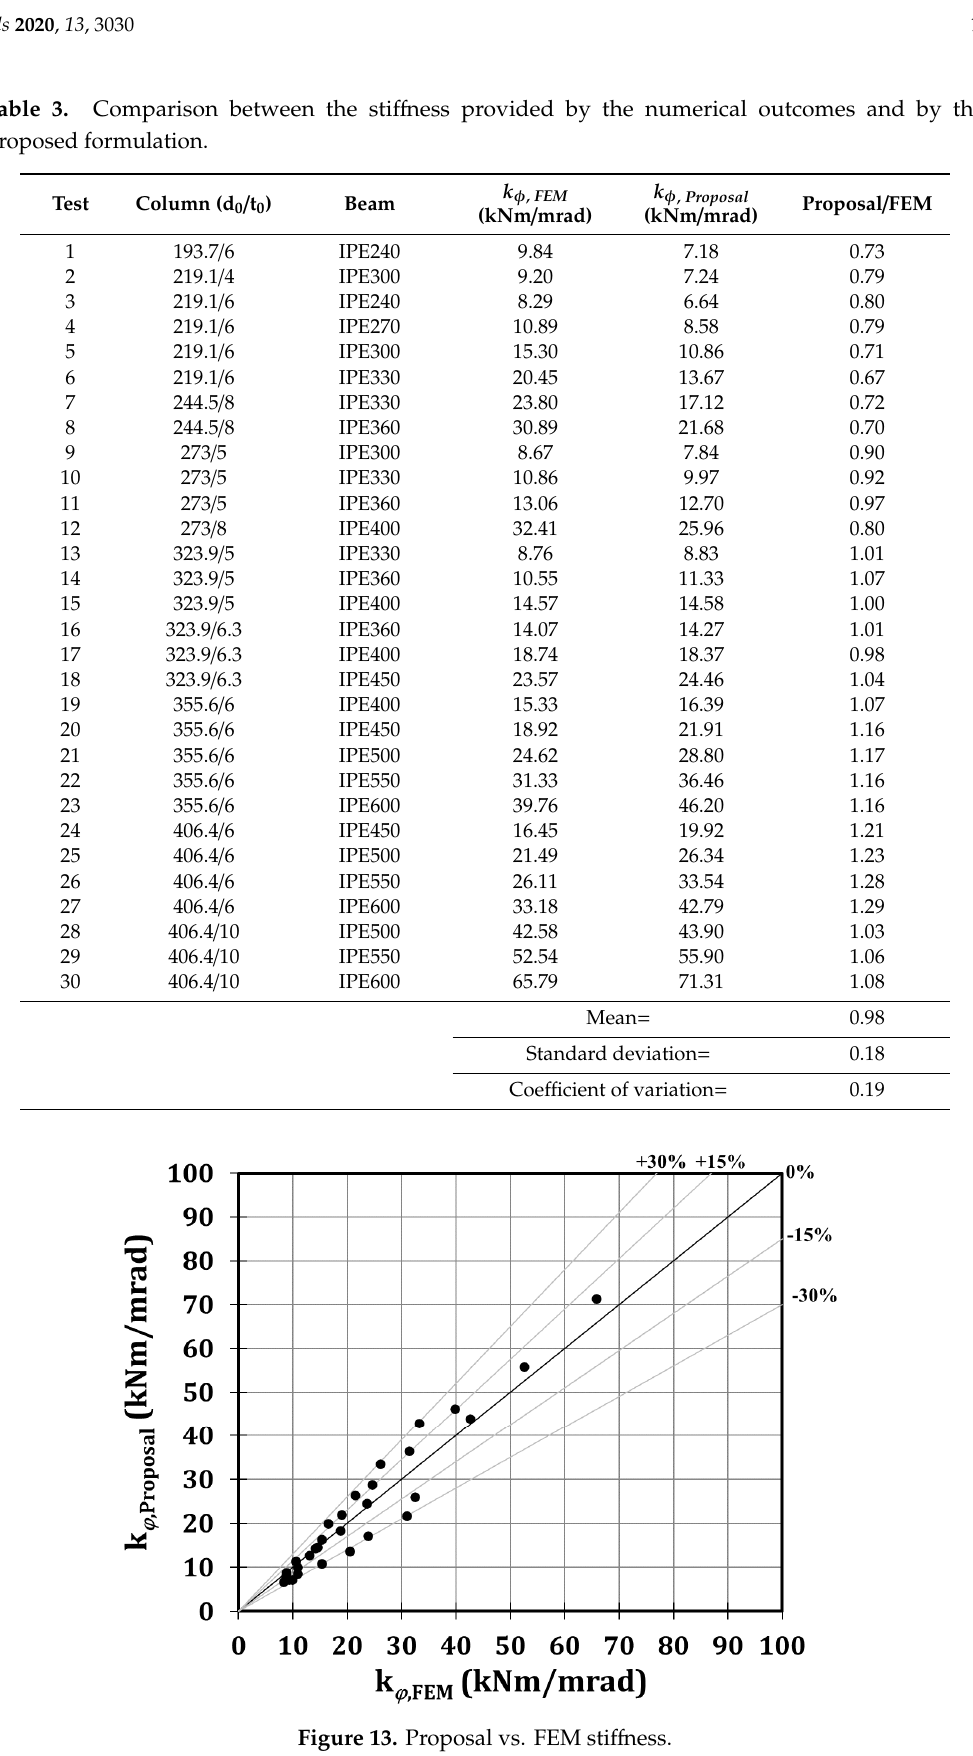
Figure 13. Proposal vs. FEM stiffness. Table 3. Comparison between the stiffness provided by the numerical outcomes and by the proposed formulation.